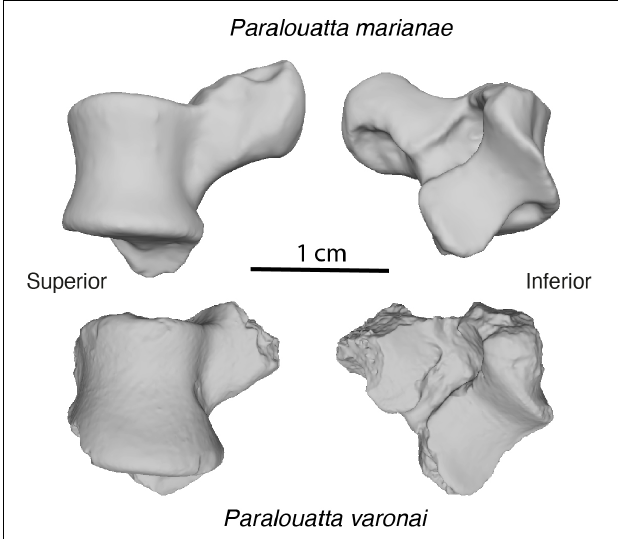
FIGURE 1 | Fossil sample under study.